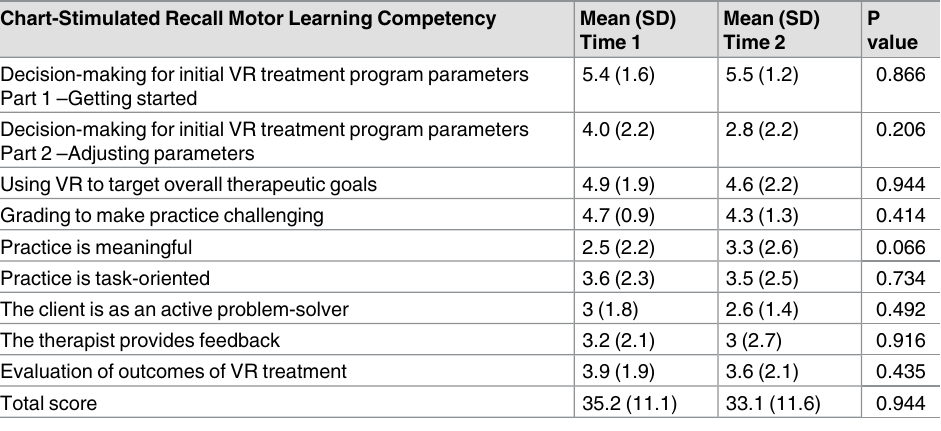
Table 4. Chart-stimulated competency ratings at Time 1 and Time